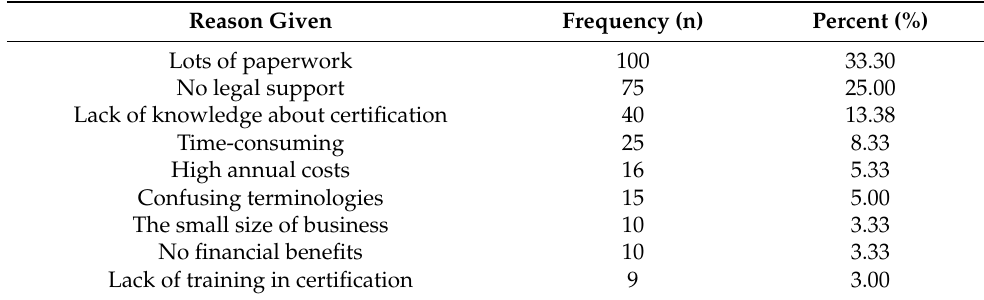
Table 5. The reasons given by rooibos farmers for failure to implement quality assurance systems.